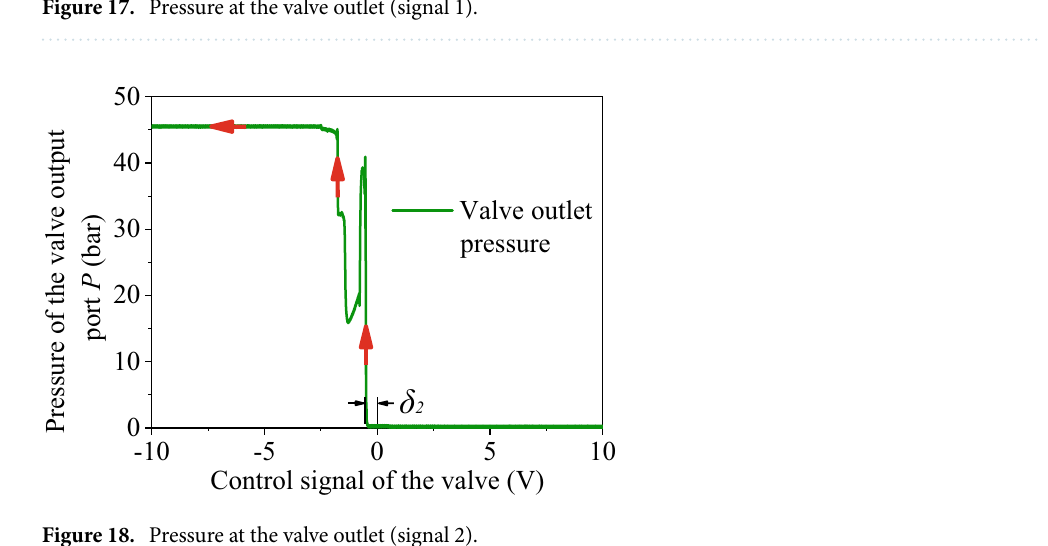
Figure 17. Pressure at the valve outlet (signal 1).